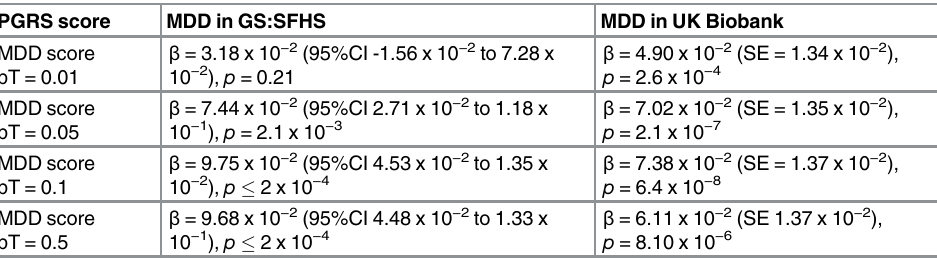
Table 3. Association between MDD-related traits in GS:SFHS and UK Biobank with the Psychiatric Genomics Consortium derived MDD polygenic risk scores. PGRS score MDD in GS:SFHS MDD in UK